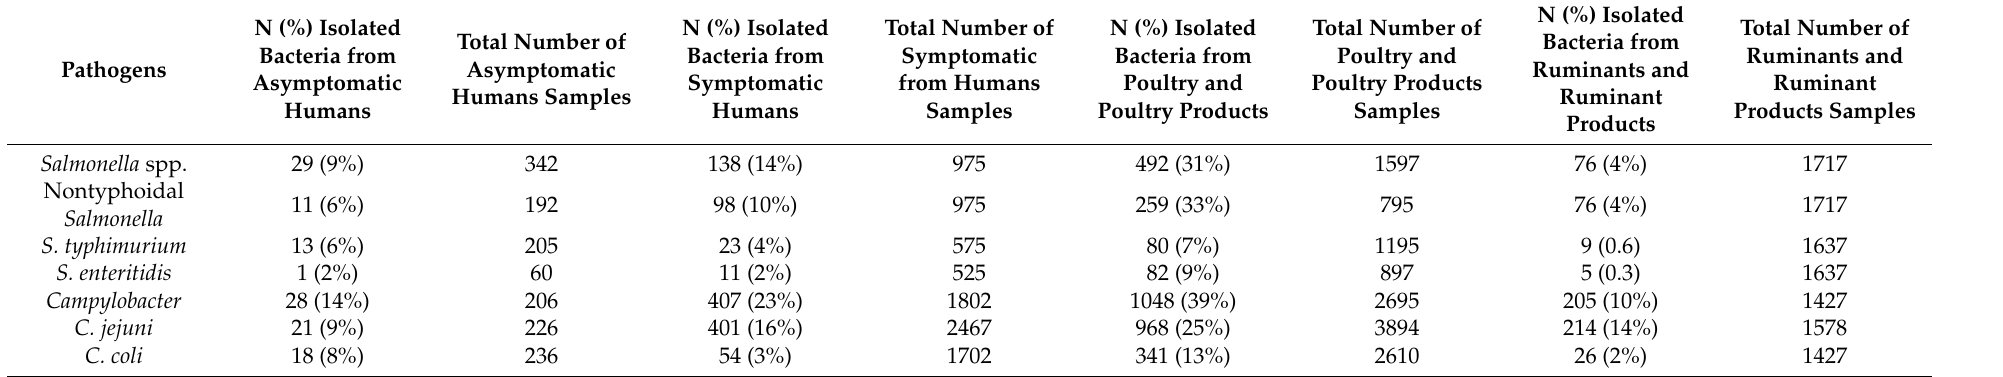
Table 2. Prevalence of Salmonella and Campylobacter and main serotypes based on the samples